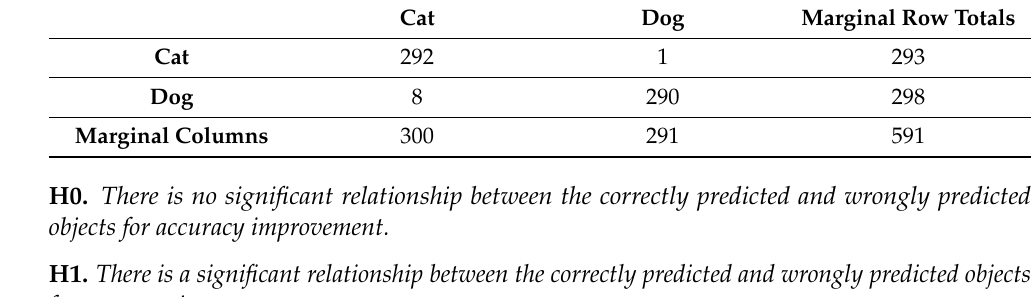
Figure 13. Comparative analysis of the performance metrics among various models using Gaussian algorithm.